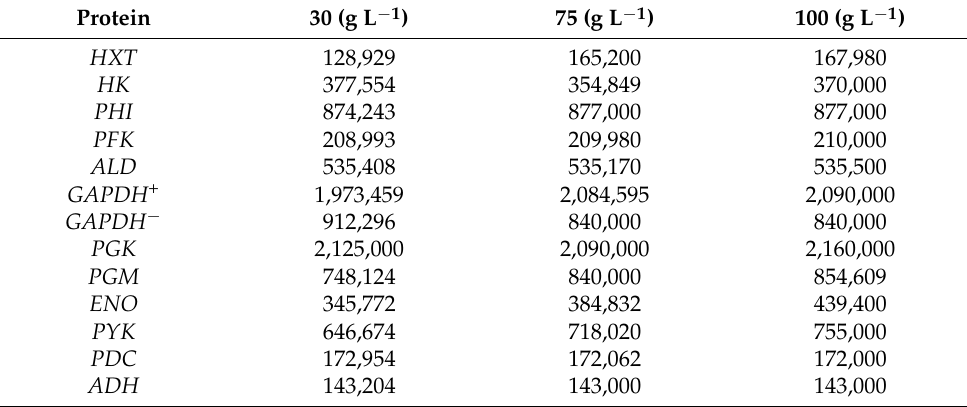
Table A1. Apparent turnover numbers (nmol min − 1 mg − 1 the initial fermentation